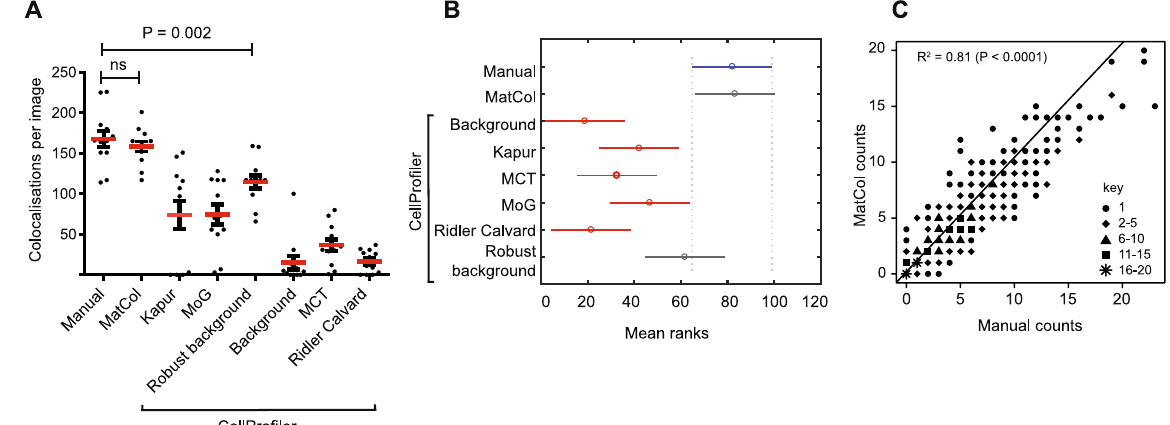
Figure 3. Comparison between the number of colocalisations by various methods. ( A ) Spread of total colocalisations in 12 images from three cell lines obtained by manual counting and automatically by either MatCol or CellProfiler using six different global thresholding methods: Kapur, MoG, Robust background, Background, MCT and Ridler Calvard. P = 0.002 comparing manual and Robust background CellProfiler results using Wilcoxon signed-rank test; ns = not significant when comparing manual and MatCol colocalisations using a Wilcoxon signed-rank test (P = 0.17). ( B ) Significance of difference in mean ranking